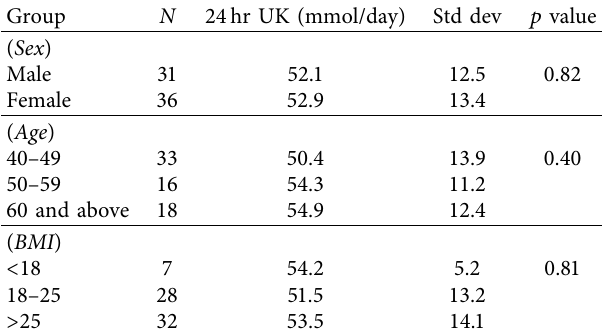
Table 3: 24hr urinary potassium (UK) excretion stratified by sex, age, and